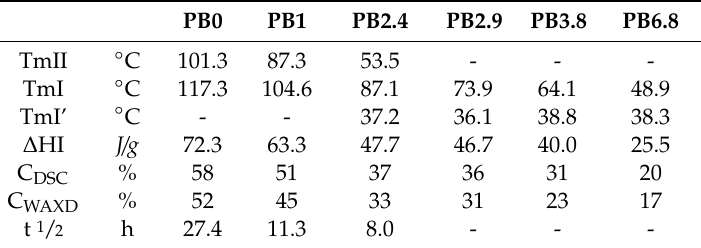
Table 3. Melting temperatures (TmI’, TmI, TmII), melting enthalpy ( ∆ HI), degree of crystallinity (C DSC , C WAXD ) and half time of the II → I phase transformation (t 1 / 2 ) of the examined